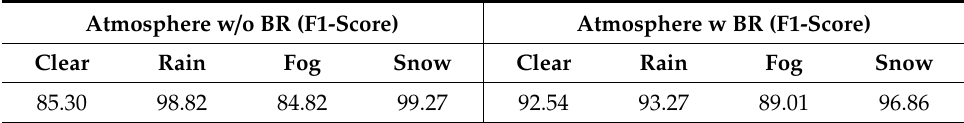
Table 9. F1-Score per class for the atmosphere region when using only the parameters: n total , n peak , x σ , n e 1 , EPW mean .